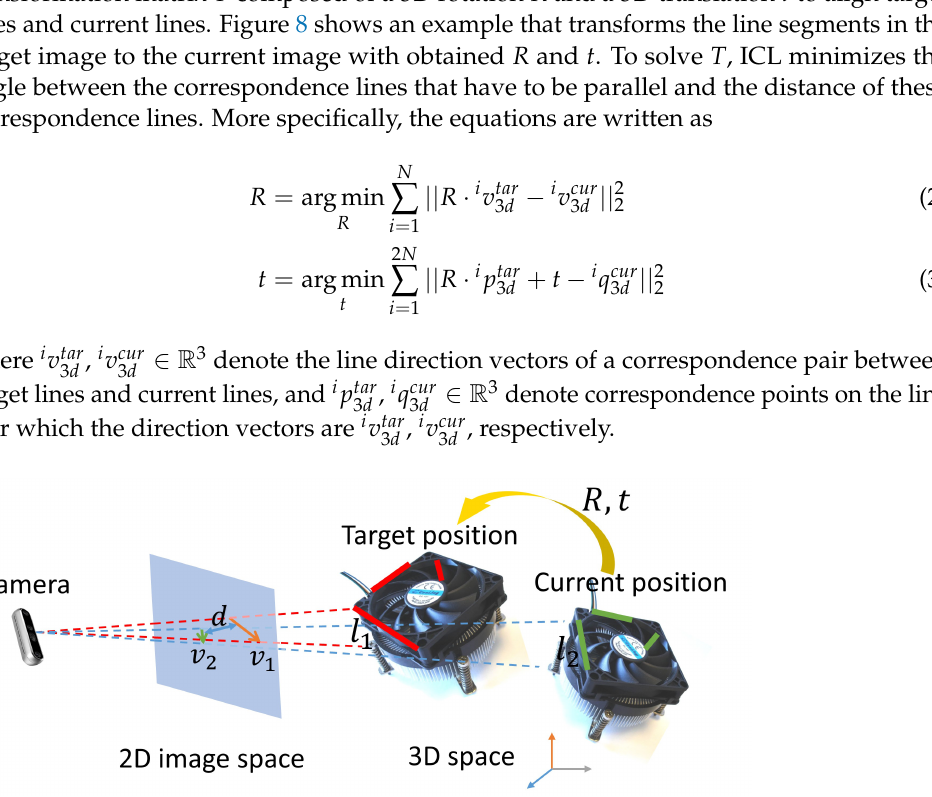
Figure 8. Find the optimal R and t by minimizing the direction between v 1 and v 2 and distance d